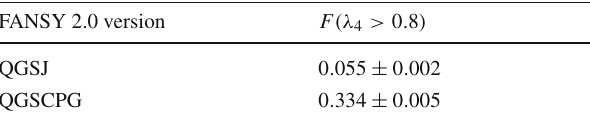
Table 2 Fractions of coplanar interactions calculated for the four most energetic stable particles, F (λ 4 > 0 . 8 ) , obtained with the FANSY 2.0 √ s = 7 TeV. The parameter λ 4 is versions (QGSJ and QGSCPG) at defined by Eq. (1)